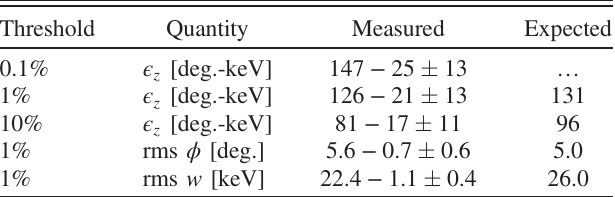
TABLE VI. Comparison of simulated (expected values)